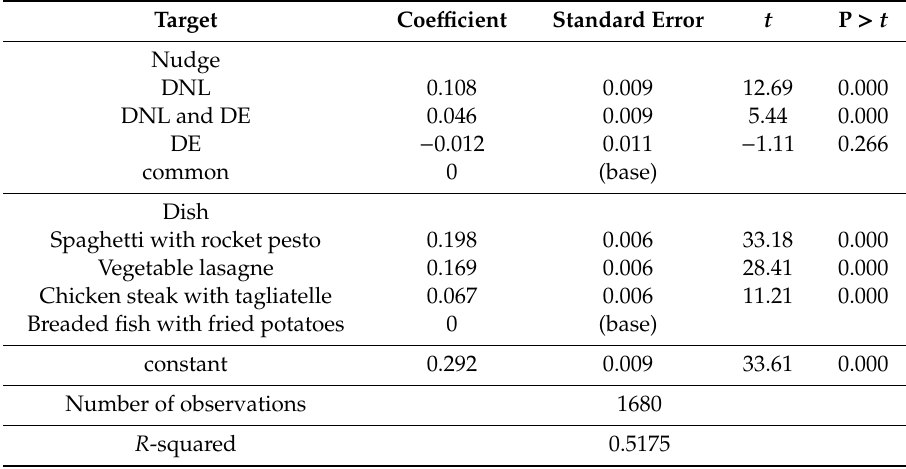
Table 6. Linear Regression (dependent variable (DV): Target dish selection, independent variable (IV): Nudge variant, Dish variant).